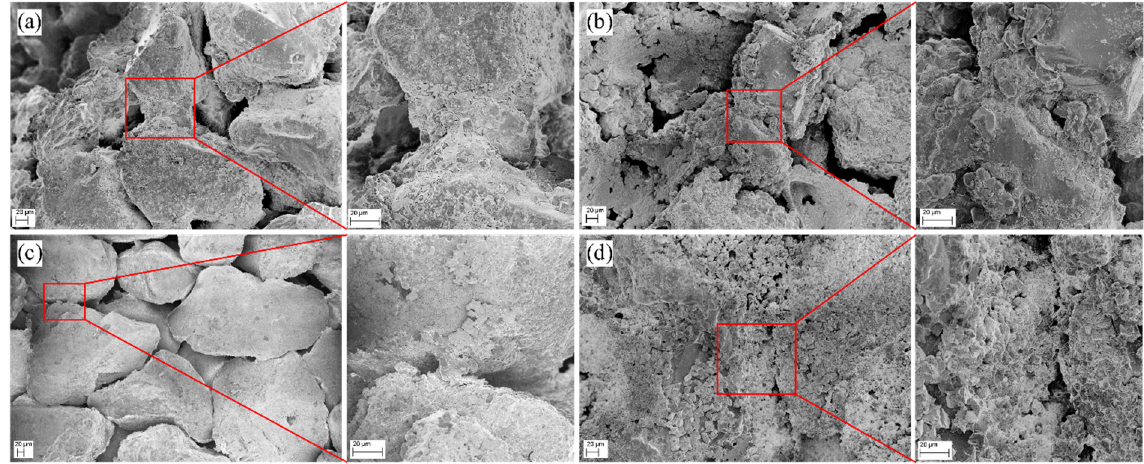
Figure 5. Microstructure of cemented sand column A with ( a ) three injection cycles and ( b ) five injection cycles; microstructure of cemented sand column B with ( c ) three injection cycles and ( d ) five injection cycles.